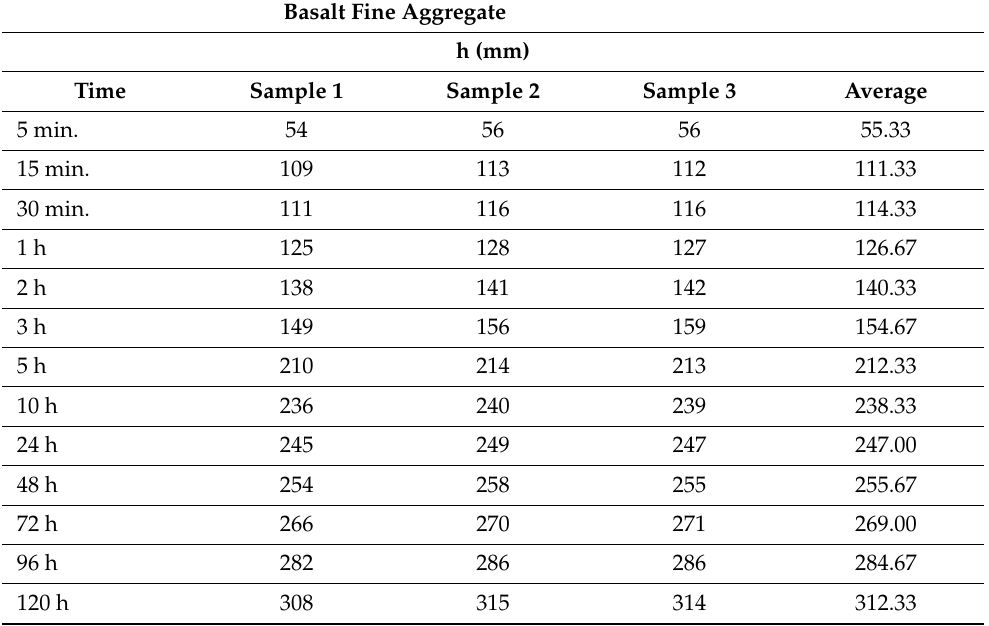
Table 5. The results of the capillary suction of the basalt fine aggregate.